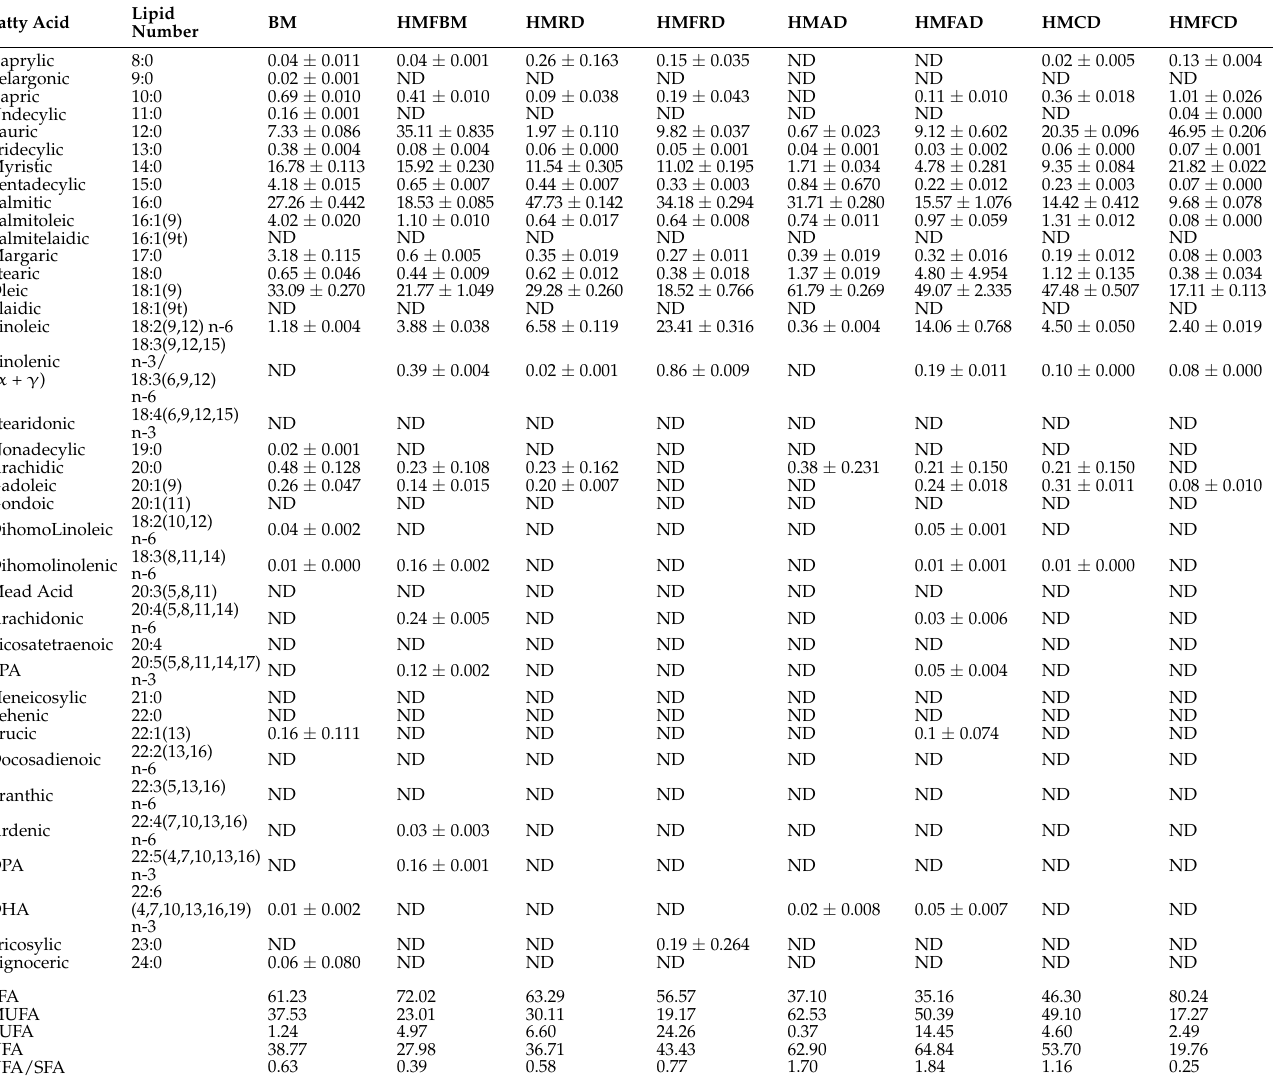
Table 2. Fatty acid composition of home-made dairy and dairy alternative